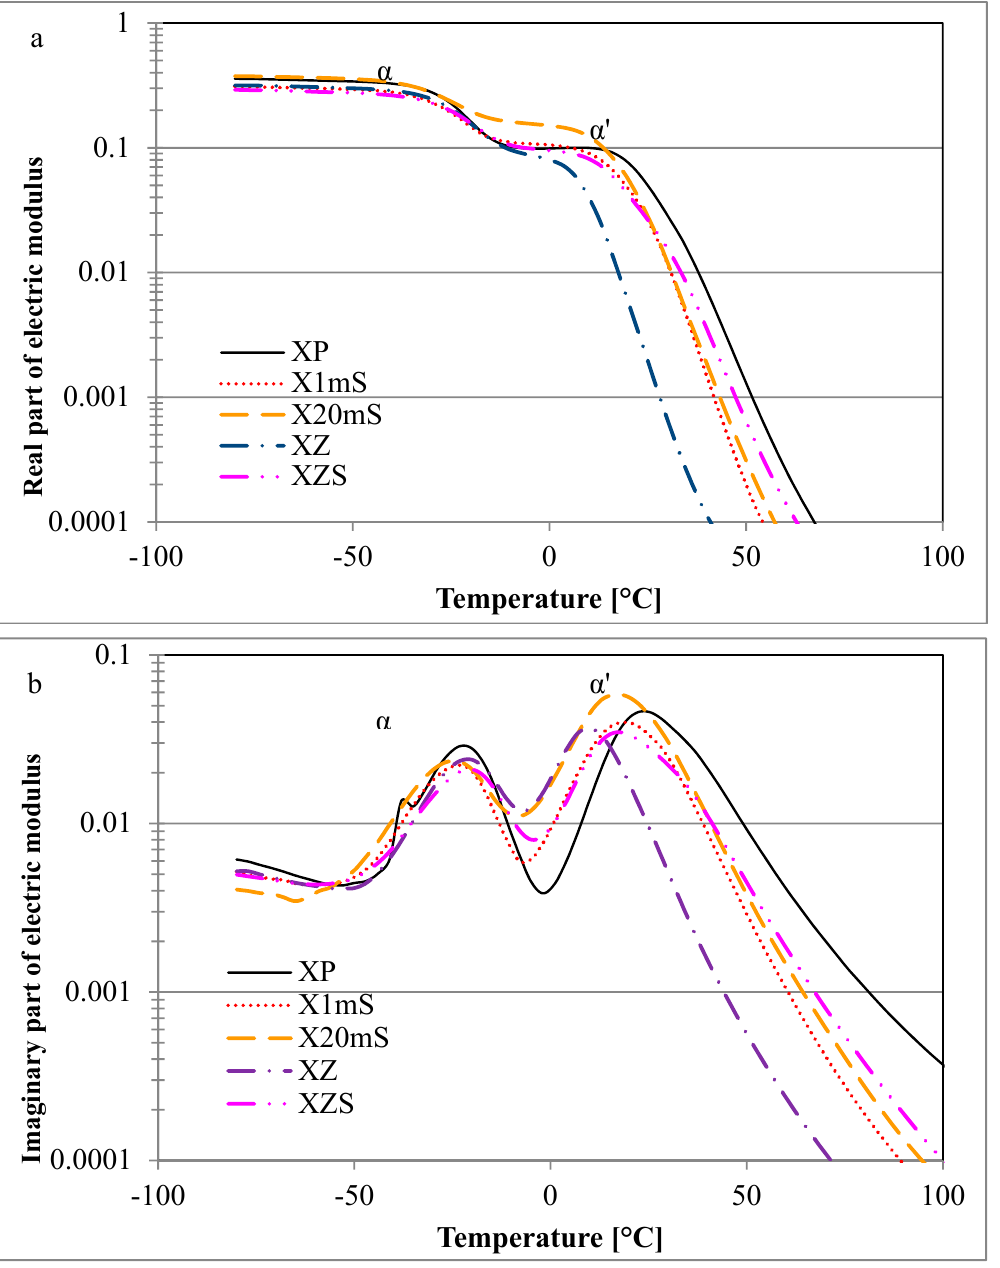
Figure 6. ( a ) The real ( M’ ) and ( b ) the imaginary ( M” ) part of electric modulus versus temperature ( T ) at 5 Hz for studied XNBR vulcanizates .